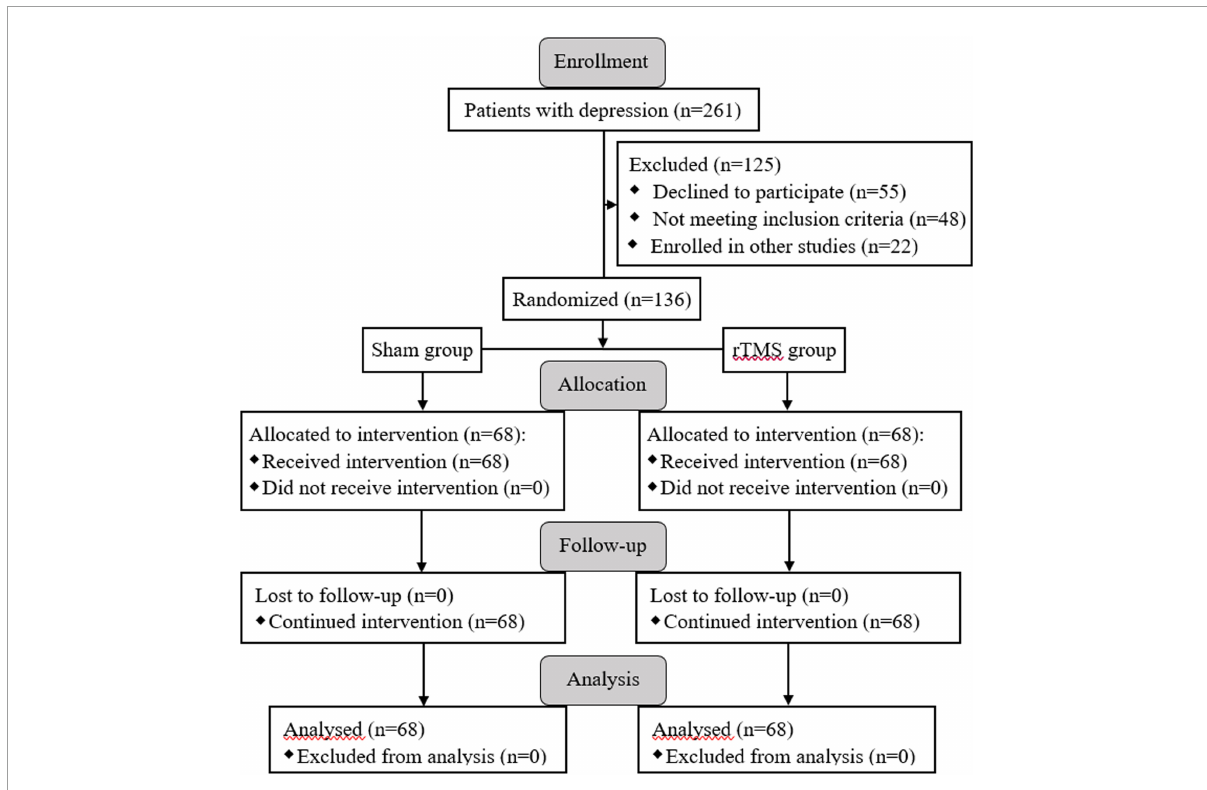
FIGURE1 Enrollment, allocation of groups, and follow-up processes are presented with the flow